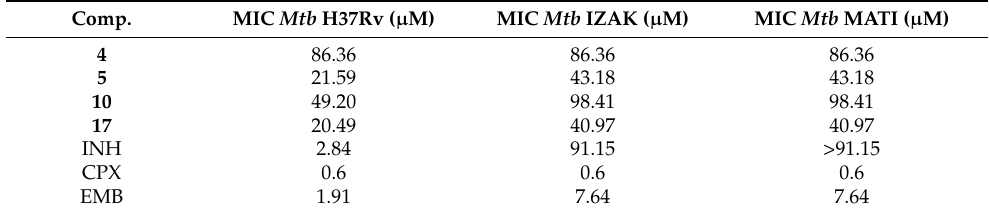
Table 2. Comparison of the antimycobacterial activity of selected compounds against collection strain of Mtb H37Rv and the clinical isolates of MDR strains of Mtb (labeled IZAK and MATI) including standards.